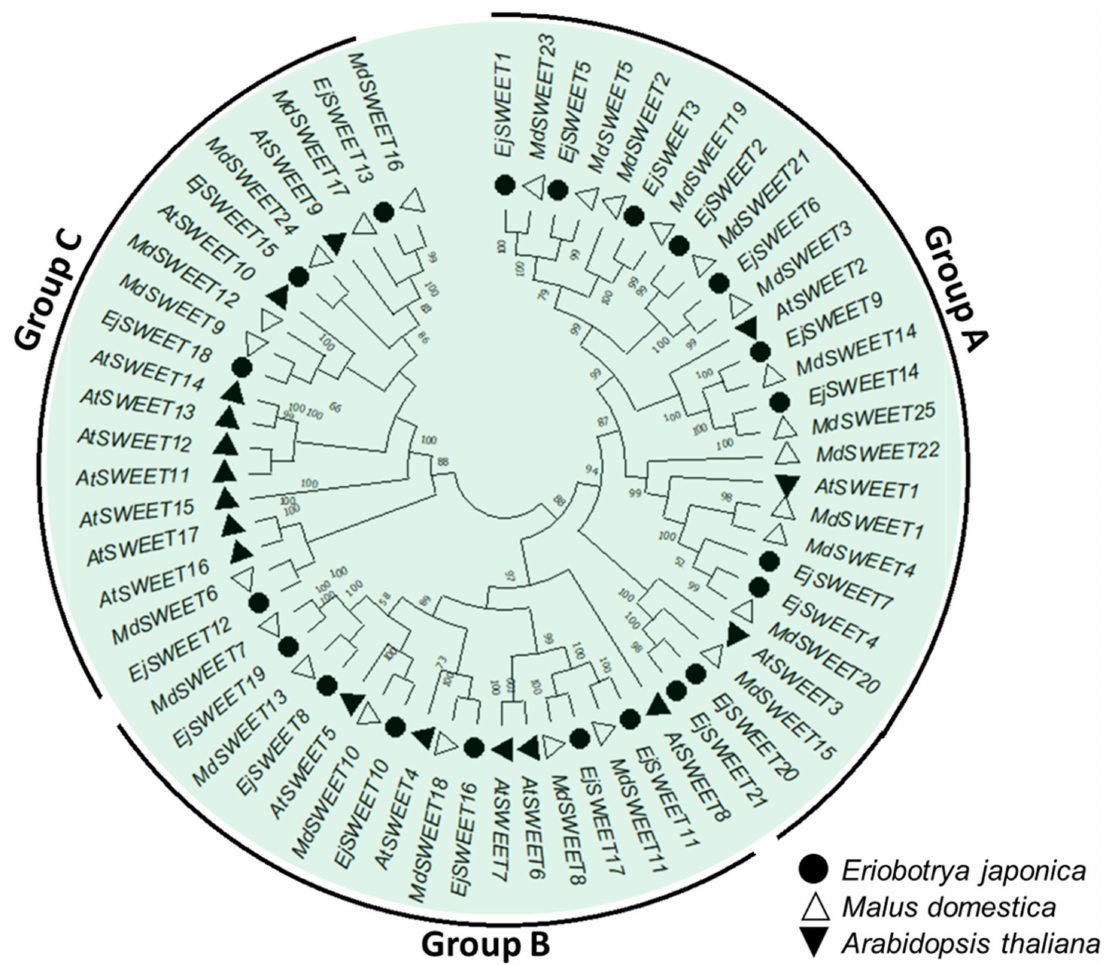
Figure 6. Phylogenetic associations of SWEET genes among loquat, Arabidopsis, and apple. SWEET genes fall into three groups labeled A, B, and C. Ej—loquat; Md—apple; At—Arabidopsis. The gene IDs of apple and Arabidopsis SWEET genes are provided in Table